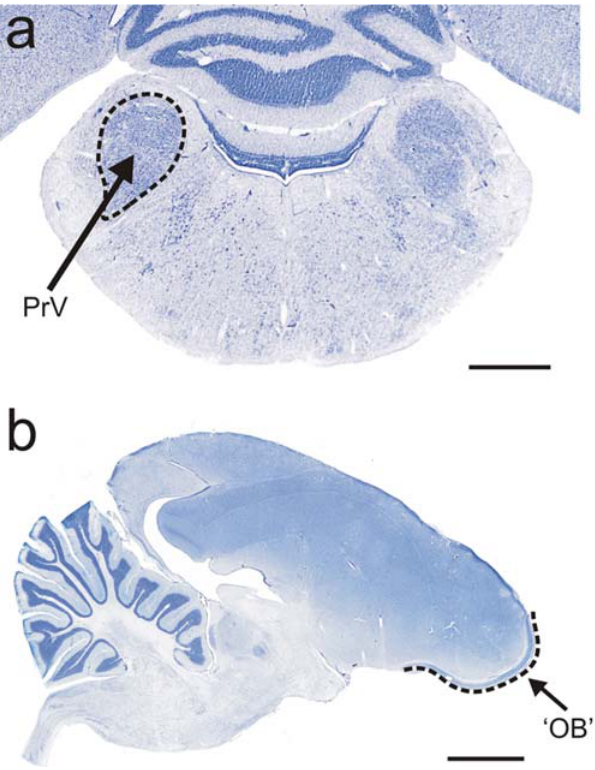
Figure 6. Principal sensory trigeminal nucleus and olfactory bulb. a, Cresyl Violet stained coronal section through the pons of a kiwi showing the large sensory trigeminal nucleus (PrV) that receives tactile input from the beak; b, Cresyl Violet stained sagittal section of a kiwi brain showing the olfactory bulb, which in the adult is a cortical-like sheet surrounding the frontal pole of the brain (bracketed by dashed line, and see Fig. 4). Scale bar: 5 mm.